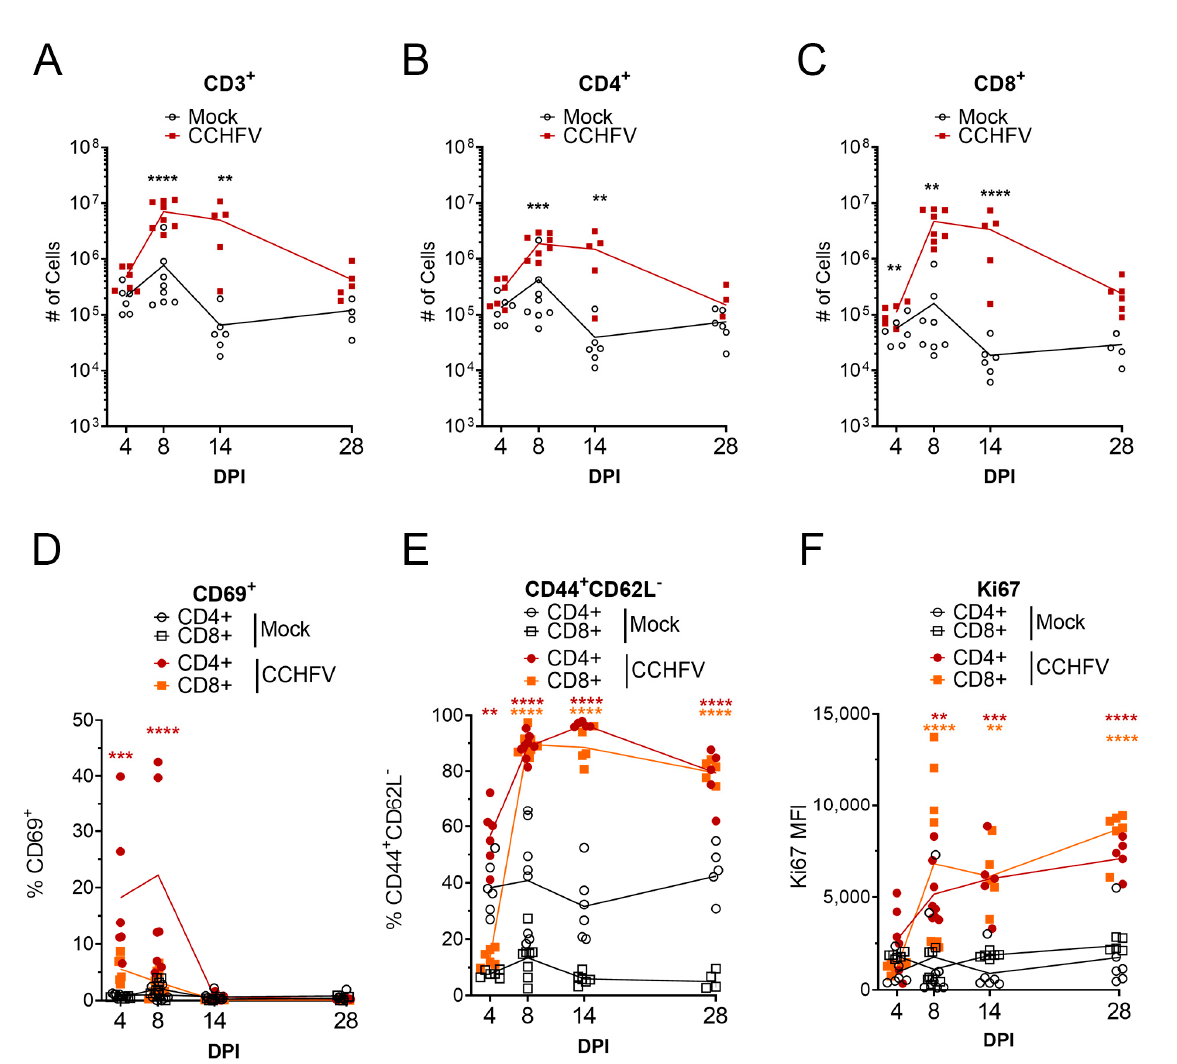
Figure 1. T-cells are robustly activated in the liver following Crimean-Congo hemorrhagic fever virus (CCHFV) infection. IFNAR − / − mice were infected with CCHFV or mock-infected. At indicated timepoints, mice were euthanized and T-cell populations in the liver analyzed by flow cytometry. CD4 + or CD8 + T-cells were identified as CD3 + B220 − and by exclusive expression of CD4 or CD8. ( A – C ) Data are presented as cell counts normalized to entire liver. ( D , E ) Data are presented at percentage of parental CD4 + or CD8 + T-cell populations. ( F ) The median-fluorescent intensity (MFI) of Ki67 is shown. ( A – F ) Data shown as individual data points with line connecting means. Statistical test comparing CCHFV-infected to mock- infected populations was performed using a two-way ANOVA with Sidak’s multiple comparison test. N = 5–8 per group. Statistical test comparing CD4 or CD8 populations from CCHFV-infected mice to respective populations in mock-infected mice was performed using a two-way ANOVA with Sidak’s multiple comparison test. N = 5–8 per group. ** p < 0.01, *** p < 0.001, **** p < 0.0001.